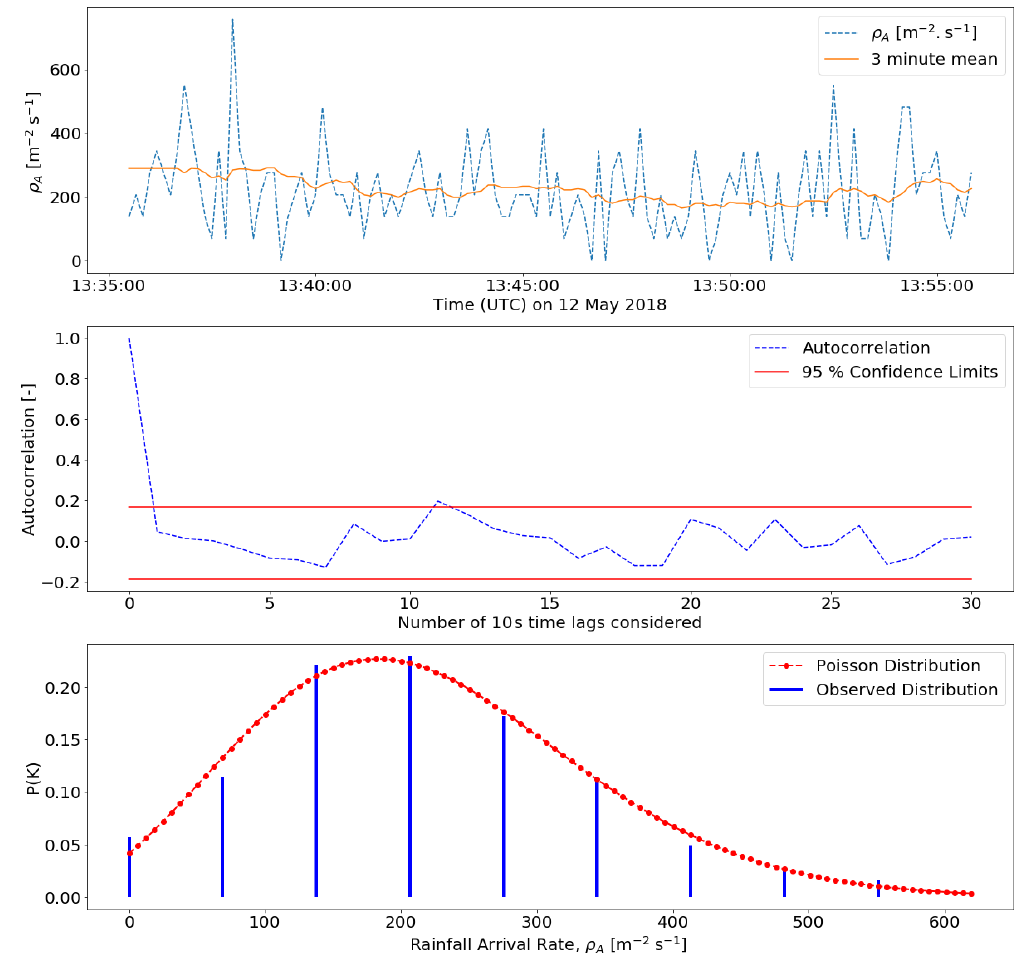
Figure 5. A patch of rainfall, with a coherence time of 20min, that can reasonably be assumed to be a sample of a Poisson process. The dispersion of the patch is 1.1 and the KL divergence is 0.01, indicating very good agreement between the observed PDF of the patch and the expected PDF from